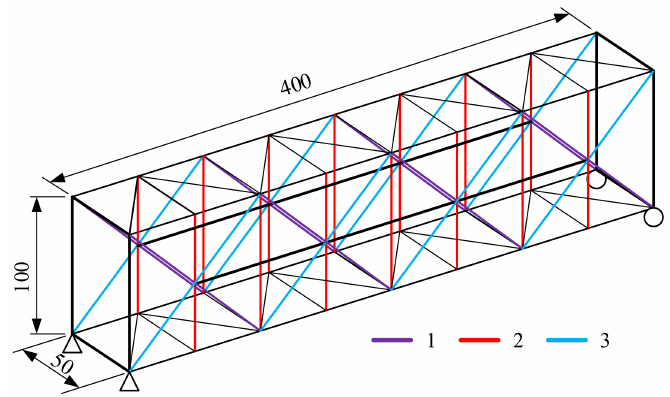
Figure 4. The simply supported truss structure. (Unit: cm).